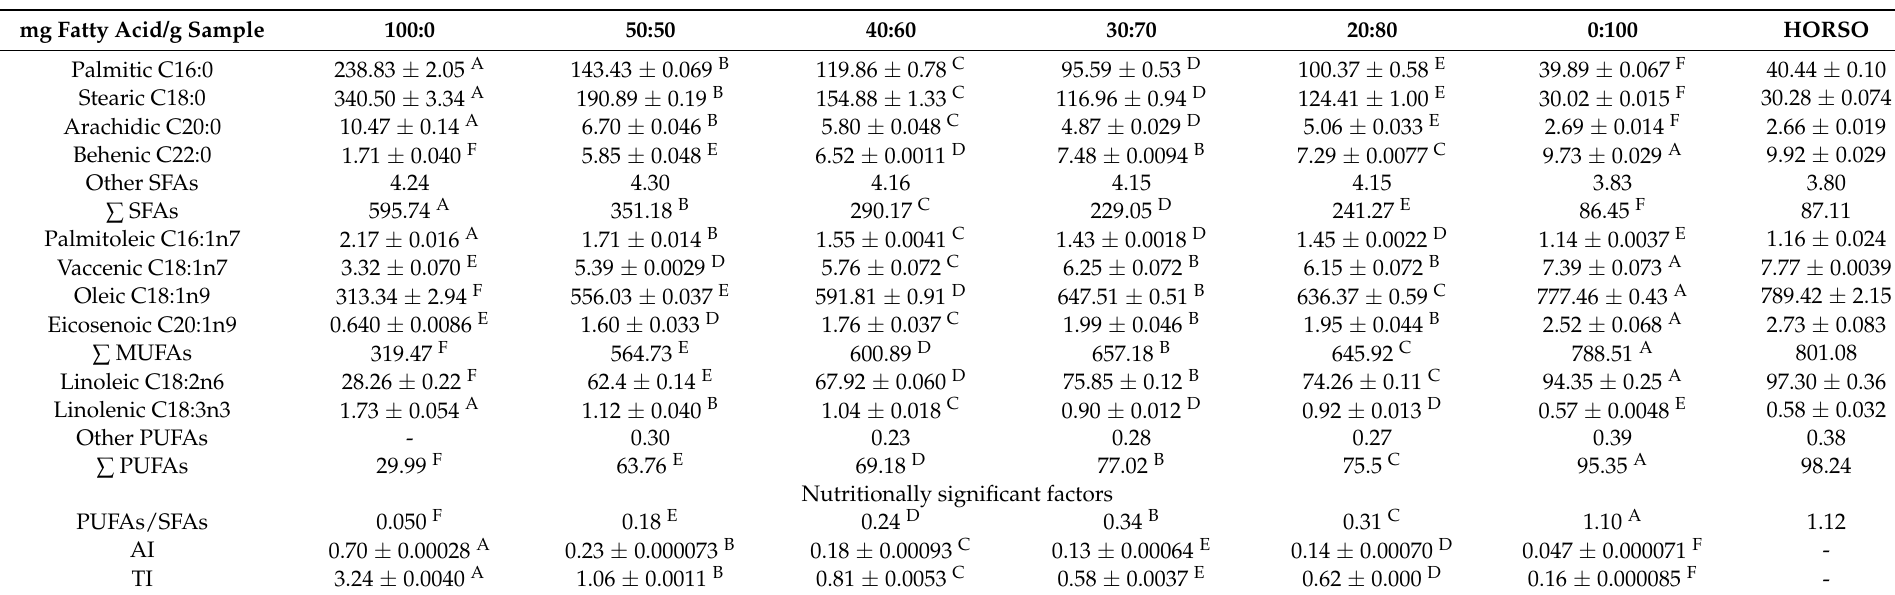
Table 1. Fatty acids (FAs) profile in the different formulated CB:OG systems and in high oleic refined sunflower oil